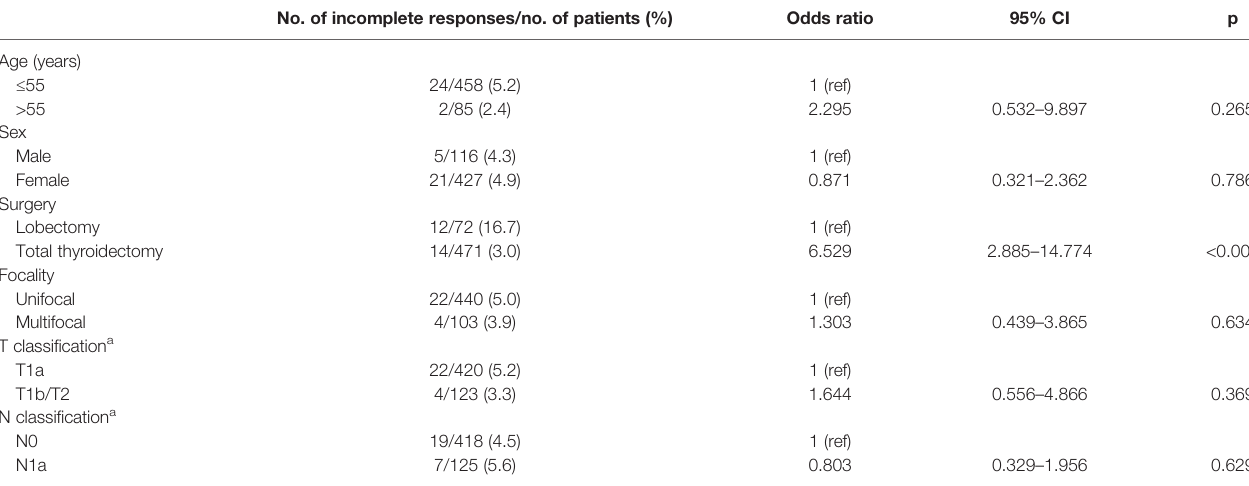
TABLE 4 | Univariate analysis of prognostic factors associated with incomplete response at the last follow-up in 543 patients. No. of incomplete responses/no. of patients